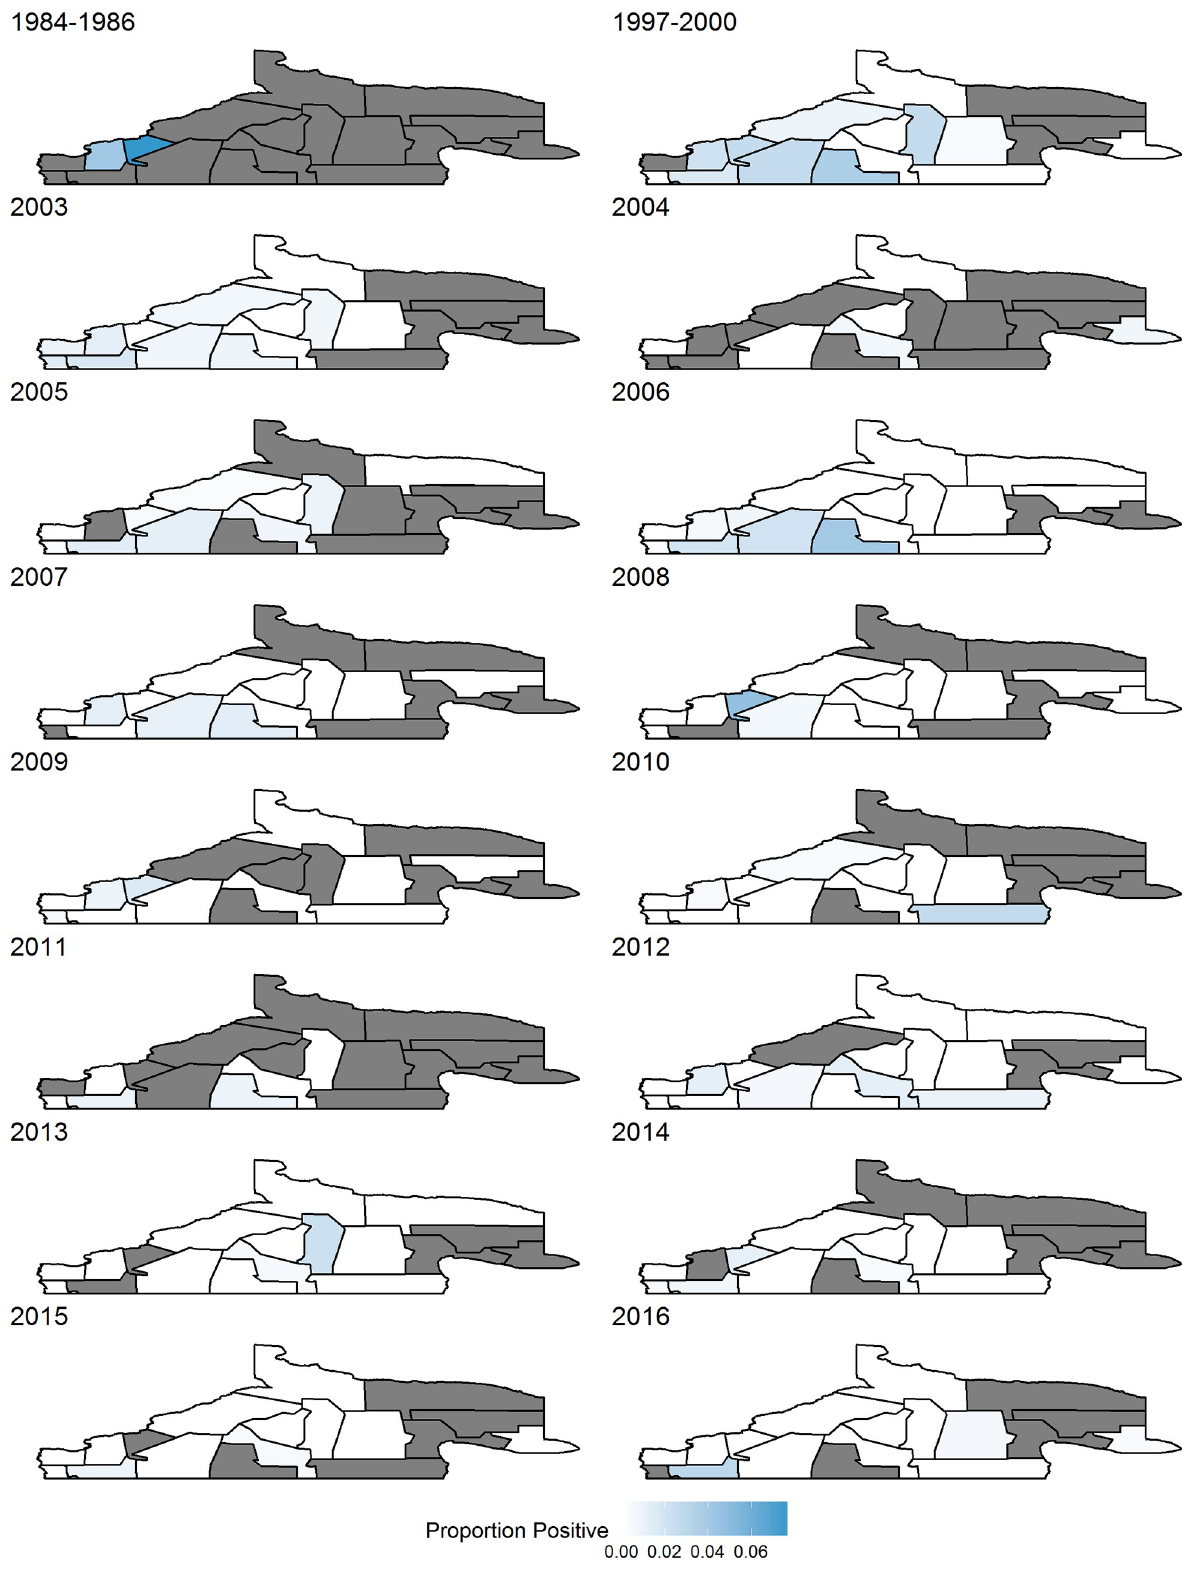
Fig 4. Model 1.1a - Spatially Correlated Error Term– u . Note that the values are zero centered and affect the relative risk on the log scale.